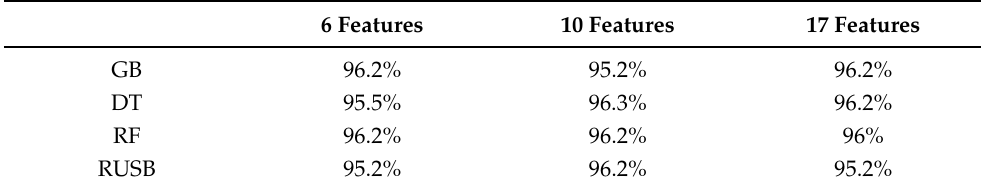
Table 12. Accuracy of the ML algorithms to predict the outcome